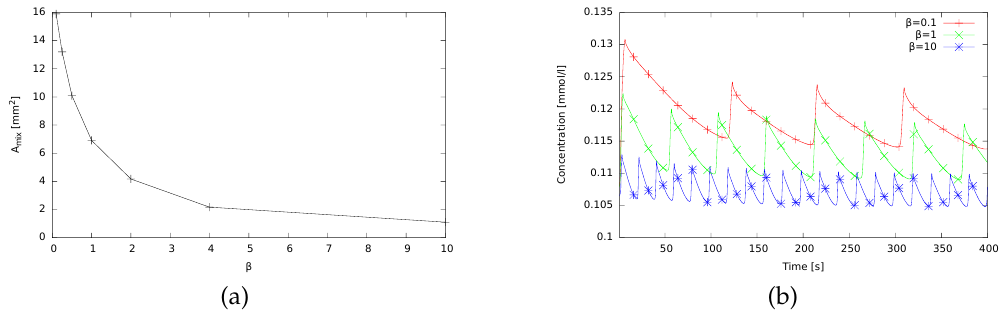
Figure 6. ( a ) Area of mixed fluid directly after the termination of the active stage of Marangoni convection from numerical simulations as a function of the volume expansion coefficient. ( b ) Relaxation oscillations of the mean solute concentration at the drop surface for different values of the volume expansion